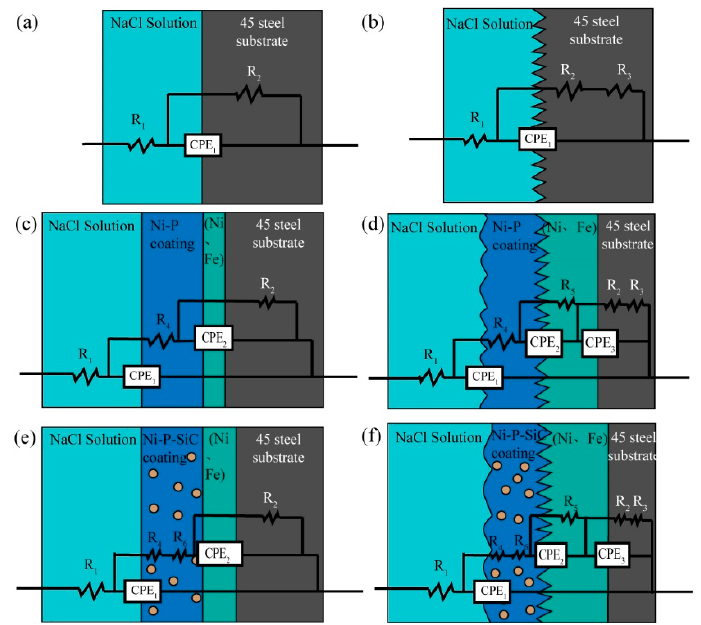
Figure 11. Nyquist plots of coatings prepared by scanning electrodeposition on 45 steel substrates with different pretreatment processes.